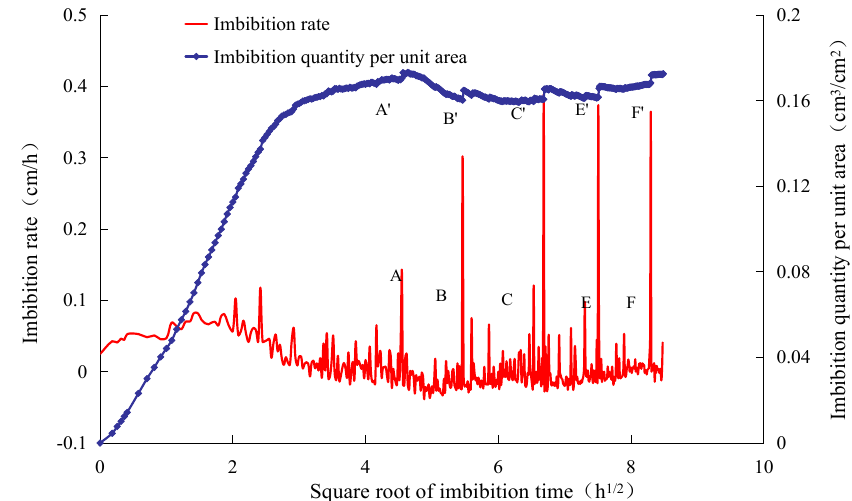
Figure 5. Determination of initiation time of induced microfractures.